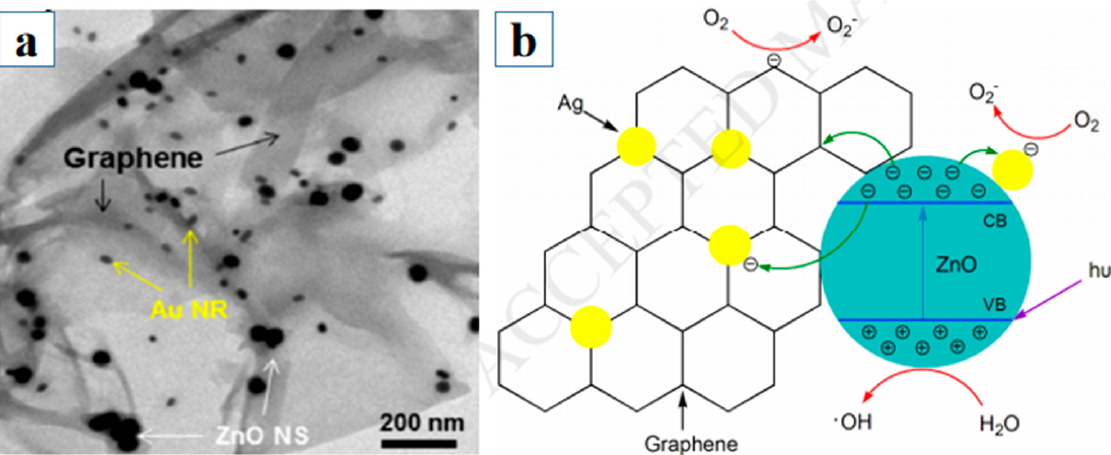
Figure 7. ( a ) SEM image of ZnO nanoparticle–Au nanorod (NR)–graphene sheet; ( b ) structural schematic diagram of the photocatalytic reduction of Ag/ZnO/Graphene nanocomposites.